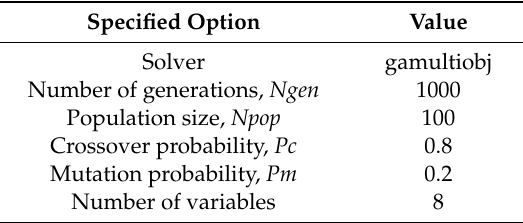
Table 3. Parameter setting of gamultiobj algorithm.